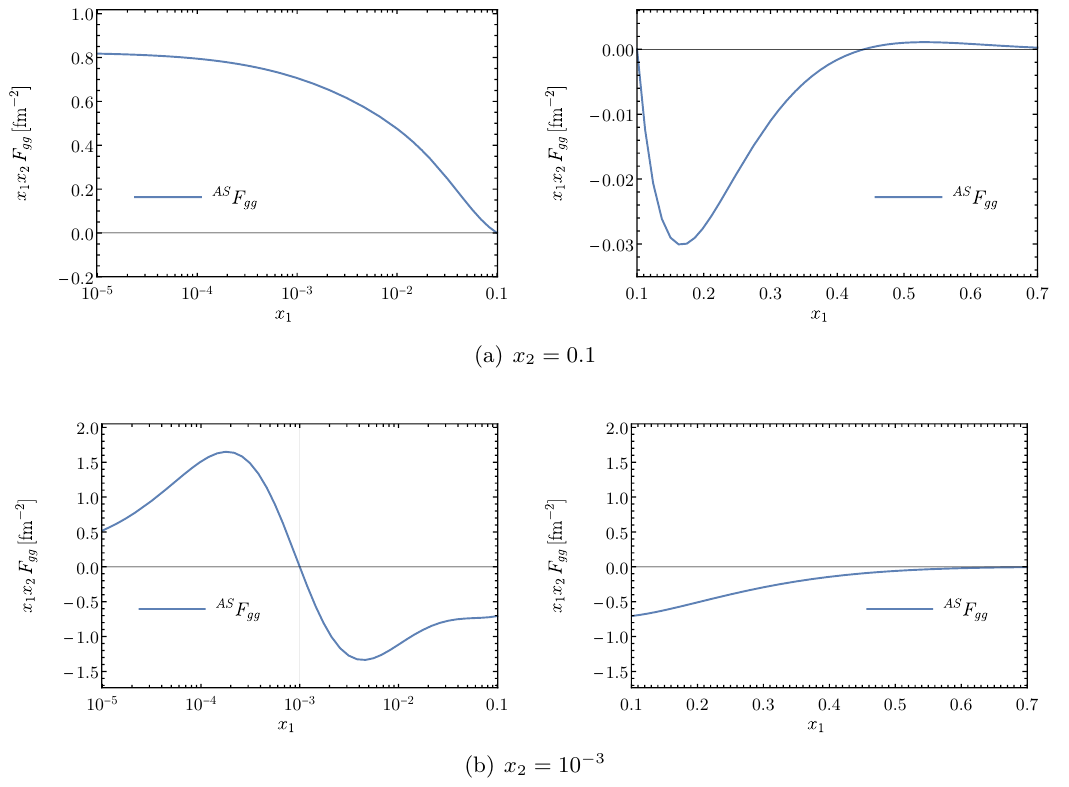
Figure 15 . The distribution AS F gg , evaluated at central values of the scales as in figure 8.